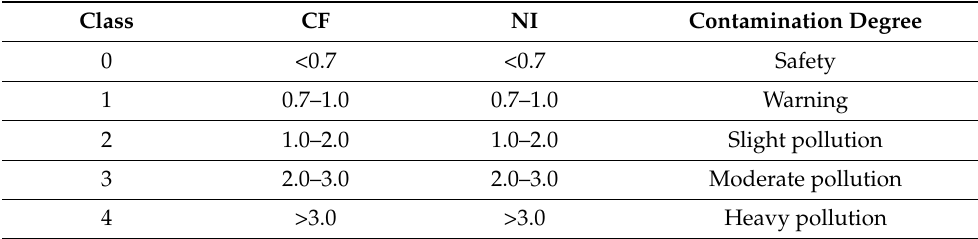
Table 2. Principle of grading for contamination factor and Nemerow composite index.